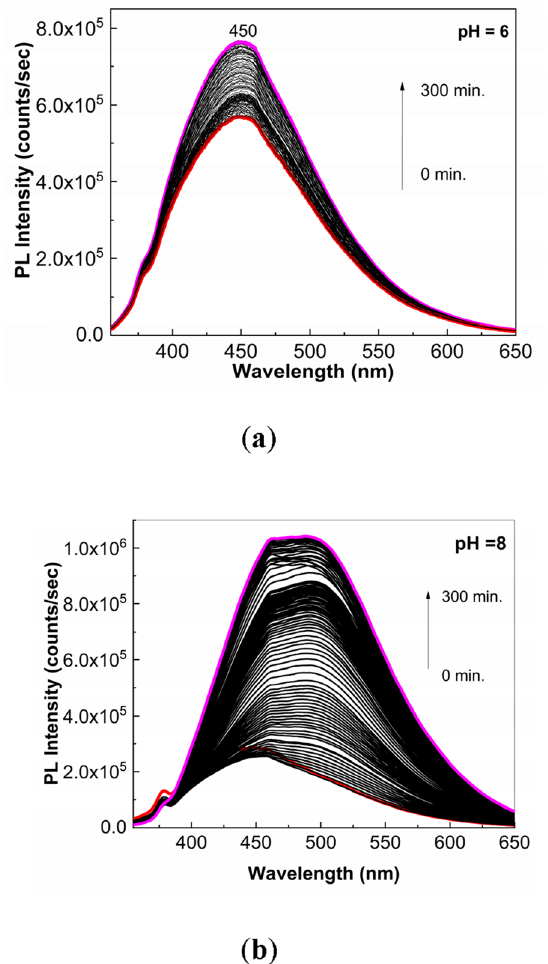
Figure 6. The PL spectra of PS ( 1 ; 2 mg/ml) in BP with the pH = 6 ( a ) and 8 ( b ) and their evolution during the 300 min. exposure to UV light. Red and magenta curves corresponds to PL spectra prior and after 300 min of UV light exposure, while the black curves show PL spectra successively